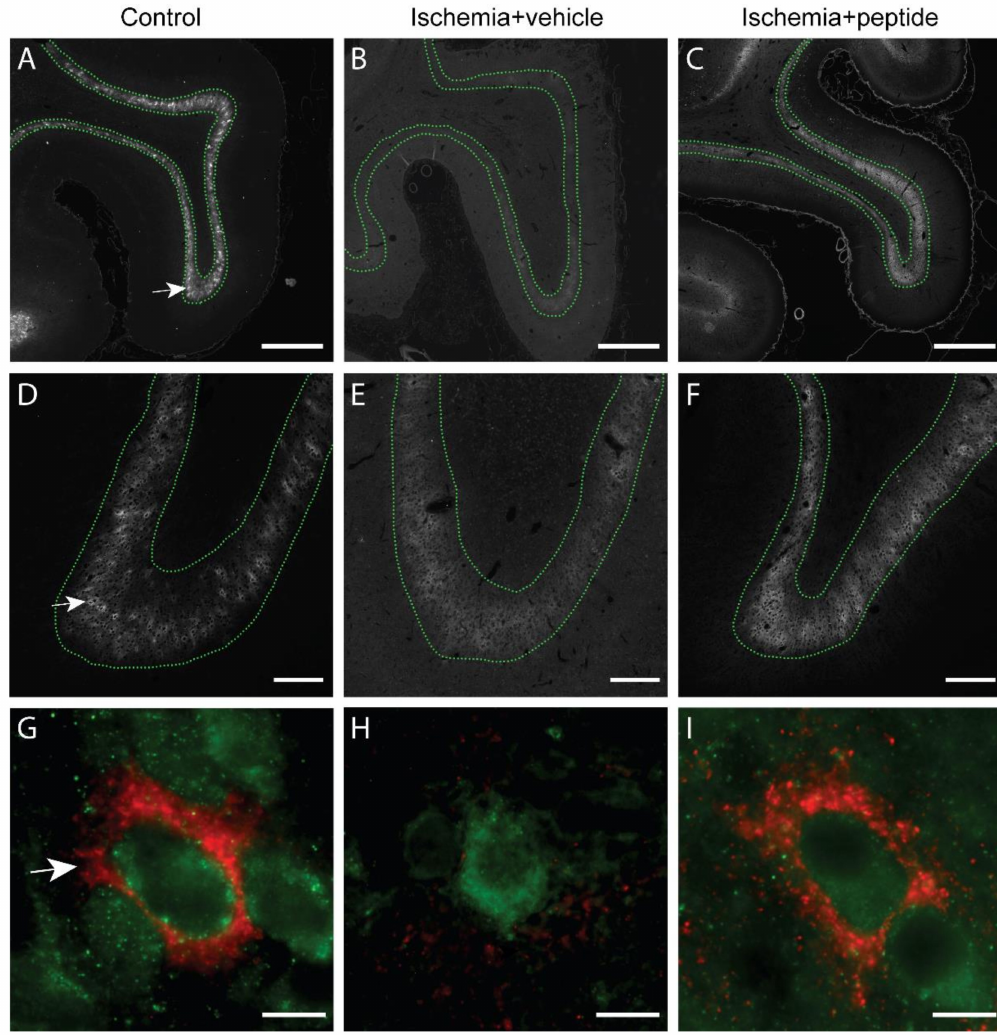
Figure 3. Immunofluorescent labelling of Wisteria floribunda agglutinin (WFA) + perineuronal nets (PNNs) and glutamate decarboxylase (GAD) + interneurons in the parasagittal cortex in the sham control ( A , D , G ), cerebral ischemia (ischemia + vehicle; B , E , H ), and cerebral ischemia + mimetic peptide treatment (ischemia + peptide; C , F , I ) groups at 7 days recovery. Note: images ( B and E ) (ischemia + vehicle group) were obtained at 5 × higher exposure times than other images (sham control and ischemia + peptide groups) to allow visualization of WFA staining. ( A – F ) show WFA staining where the layer 6 region is defined within dotted lines. ( G – I ) show WFA + PNNs (red) with GAD + interneuron (green) staining. PNNs are indicated by white arrows ( A , D , G ). Scale bars: 1 mm ( A – C ); 200 µ m ( D – F ); 10 µ m ( G – I